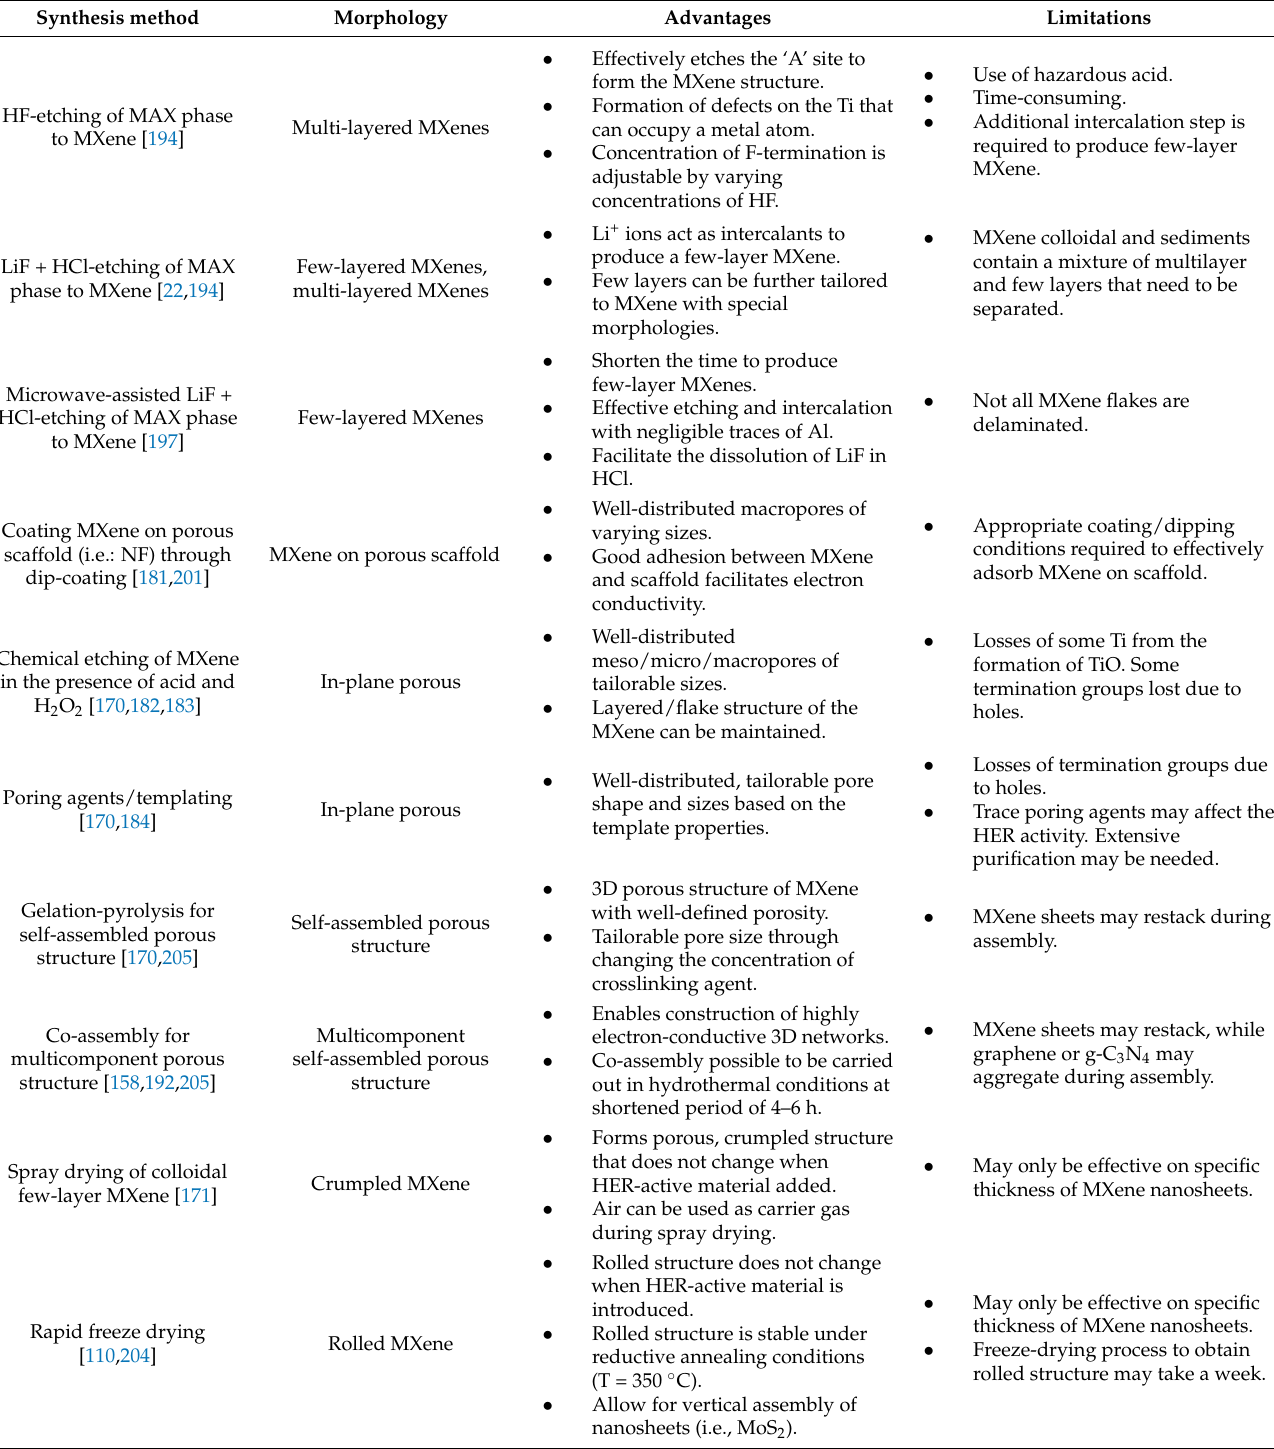
Table 4. Summary of the advantages and limitations of some known preparation methods of MXenes with different